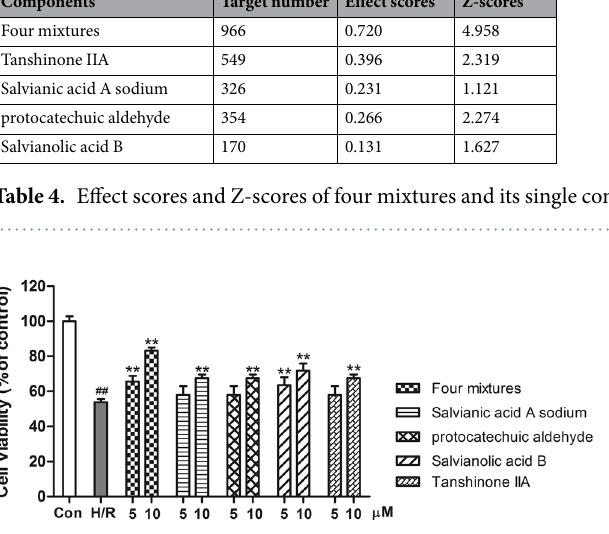
Figure 3. Effects of single compounds and four mixtures on H/R-induced H9c2 cell injury. Cell viability by CCK-8 assay. ## P < 0.01 vs. Con; ** P < 0.01 vs. H/R. Data are shown as the mean ± SD of three independent